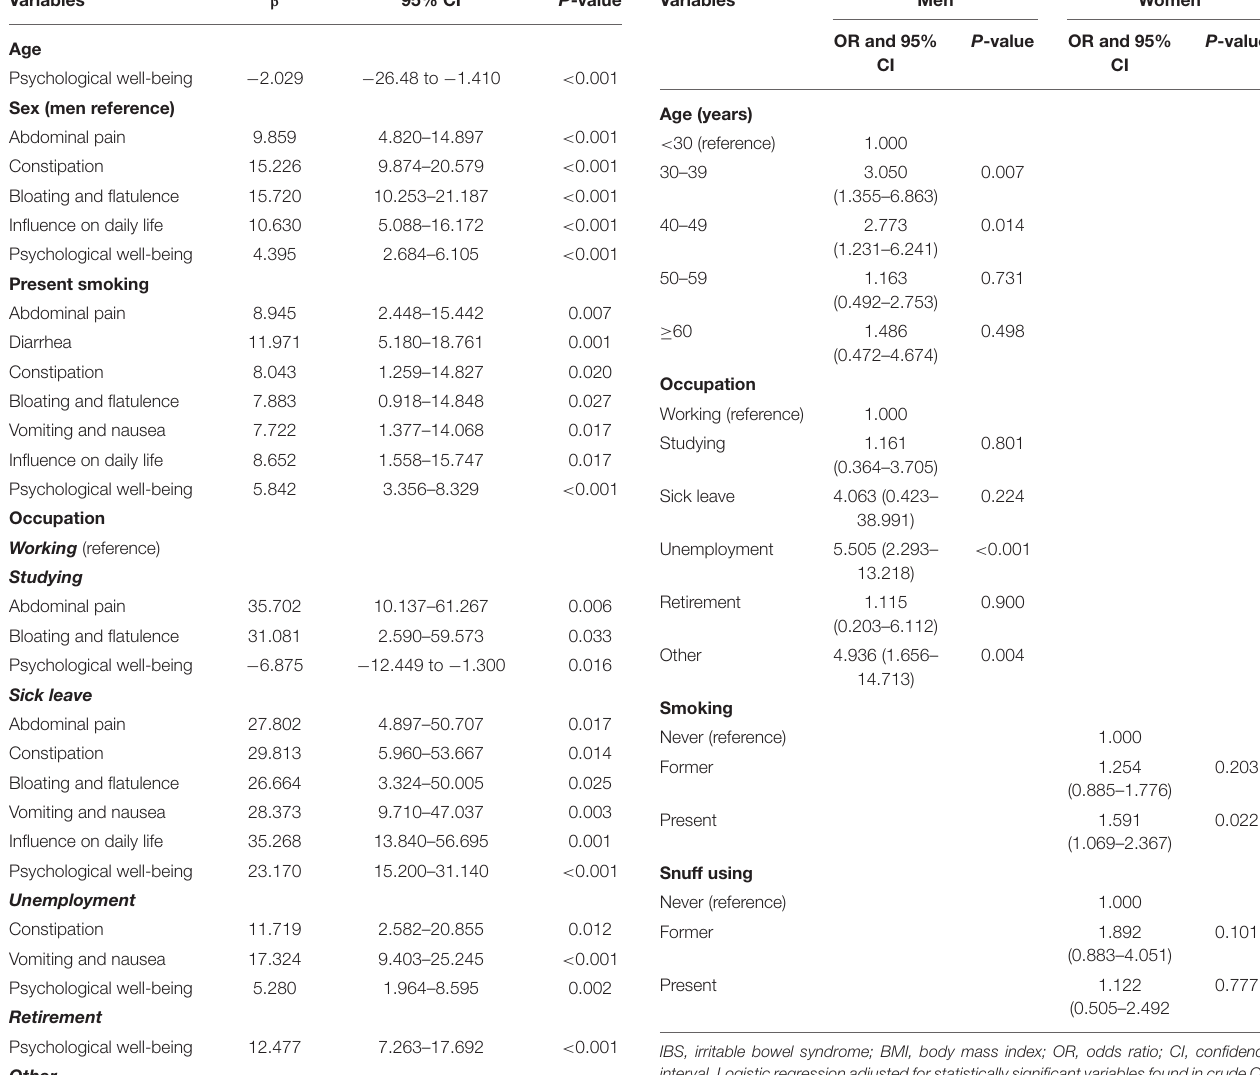
TABLE 6 | Associations between sociodemographic factors, lifestyle habits and IBS stratified by sex. Variables